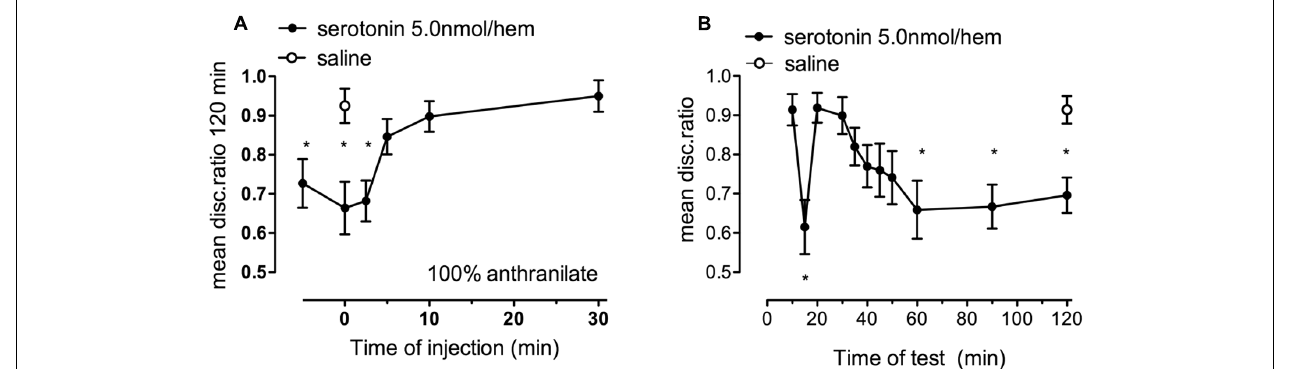
FIGURE 3 |The effect of serotonin on memory retention in chicks given strongly reinforced training. (A) 5.0 nmol/hem serotonin resulted in the inhibition of memory consolidation when injected between − 5 and + 2.5 min relative to training, n = 16–19 per